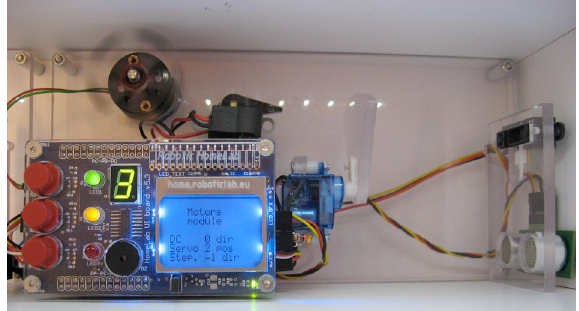
Figure 3. Robotic HomeLab kit test bench in Robolabor.ee